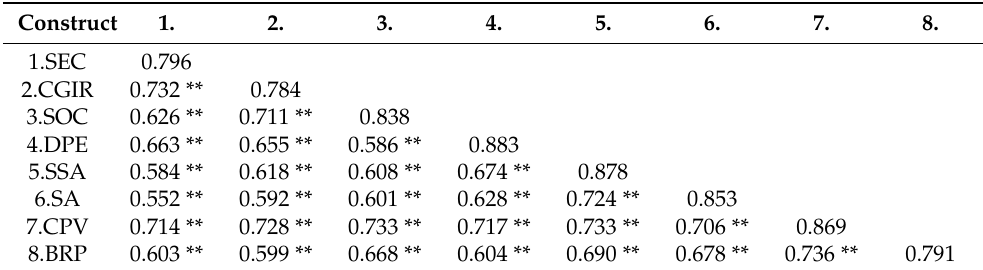
Table 5. Discriminant validity